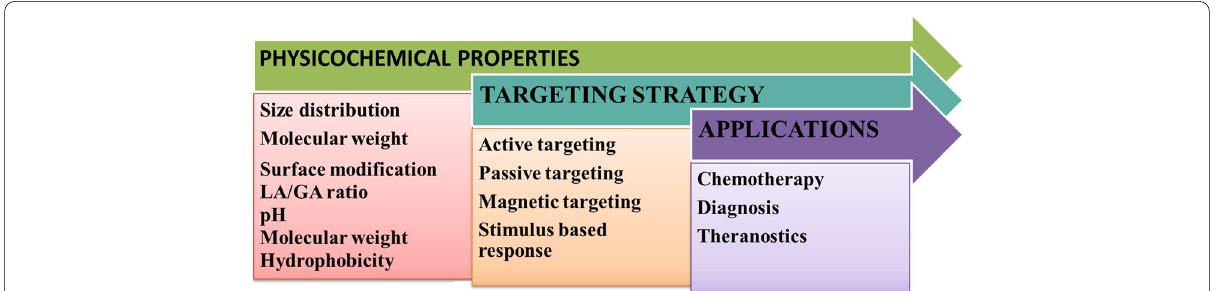
Fig. 1 Properties of nanoparticle, its applications in oncology and targeting strategies. Different physicochemical properties of polymer and NP play a vital role in designing a suitable carrier with desired properties for targeted delivery. LA: lactic acid, GA: glycolic